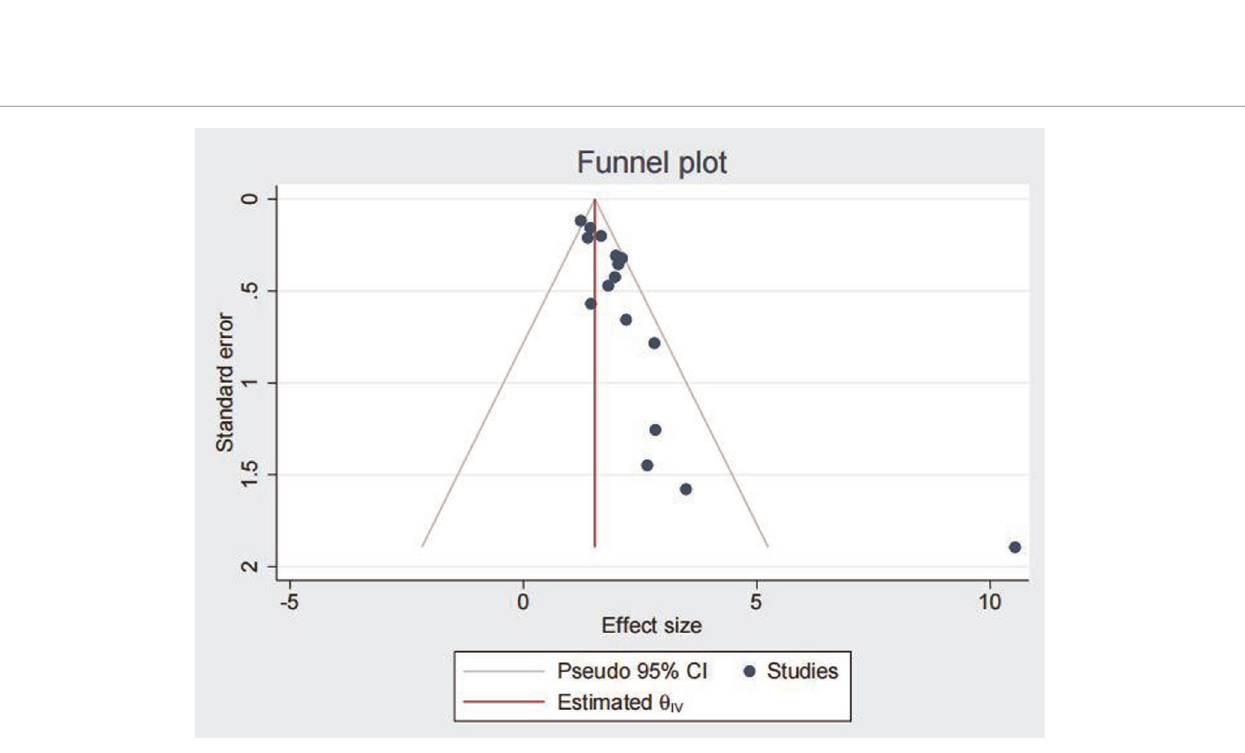
FIGURE 5 | Funnel plot, publication bias